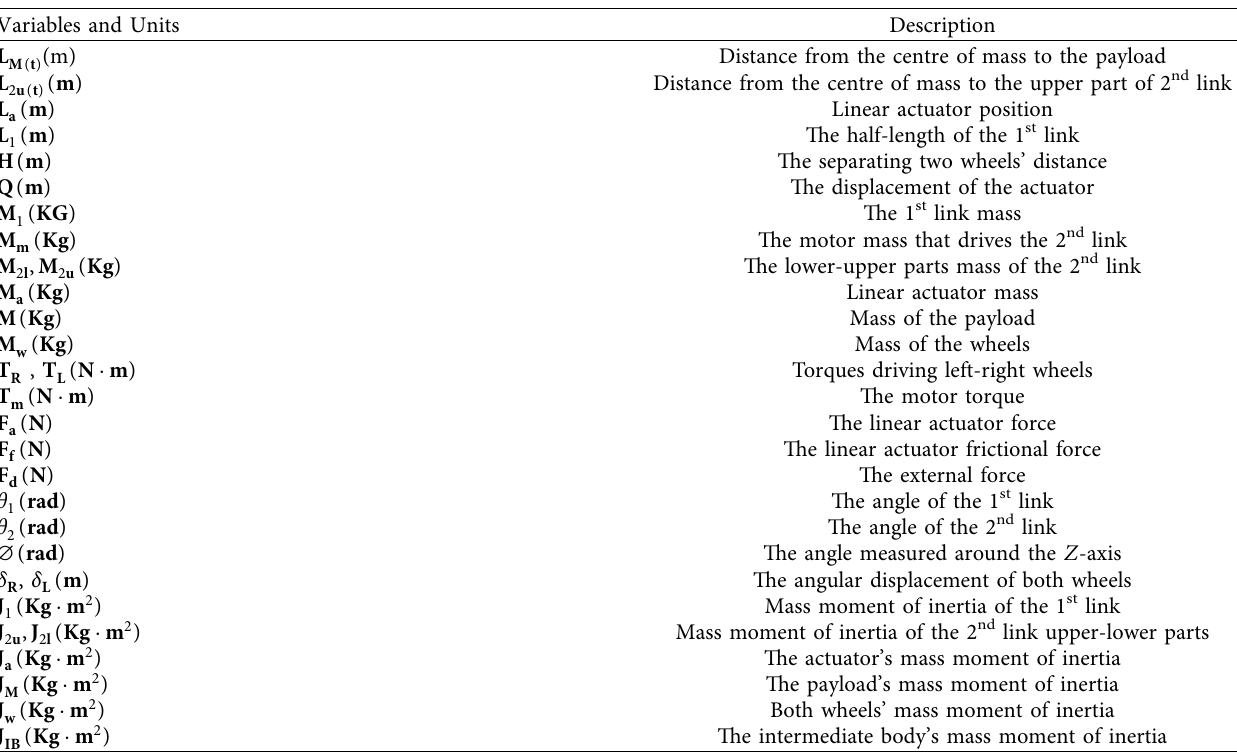
Table 4: Te utilised terms and their defnitions